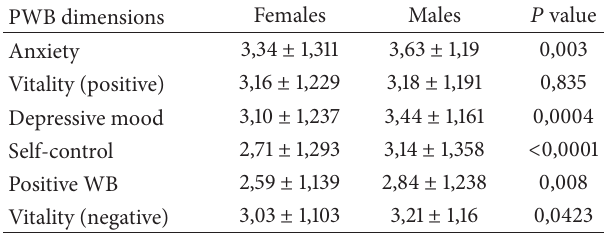
Table 1: Comparison of the six dimensions of PWB, between females and males. Results are reported as mean ± SD. 𝑃 value has been calculated by Student’s 𝑡 -test between each two groups.